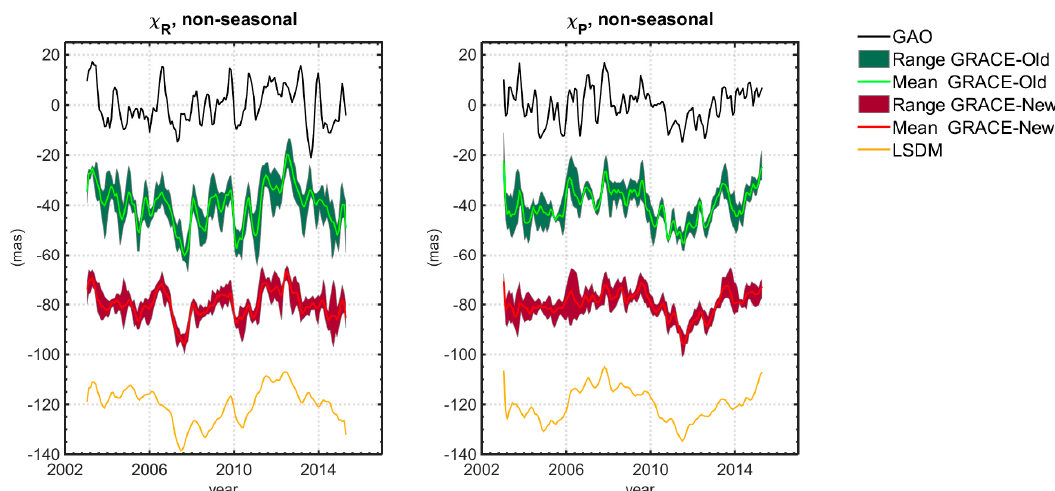
Figure 4. Comparison of mean value with ranges between minimum and maximum for χ R and χ P of non-seasonal variation in HAM for old and new GRACE solutions. Time series of GAO and HAM from the LSDM are provided for comparison. The units are milliseconds of arc (mas). For better visibility, a bias was added to various HAM in order to shift them relative to each other.